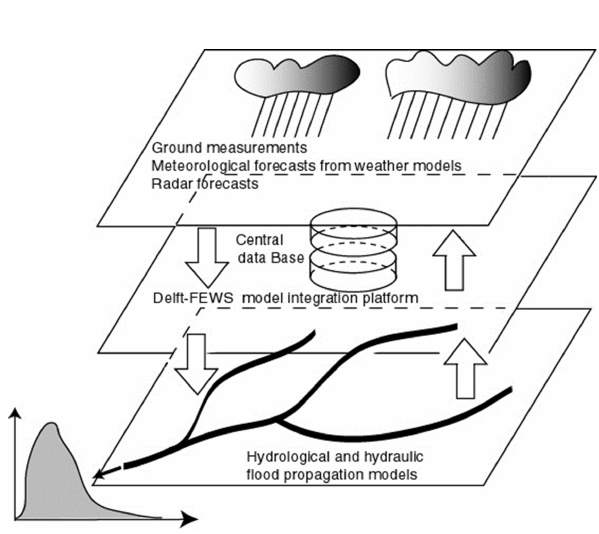
Figure 7. Empirical rainfall thresholds for landslides.